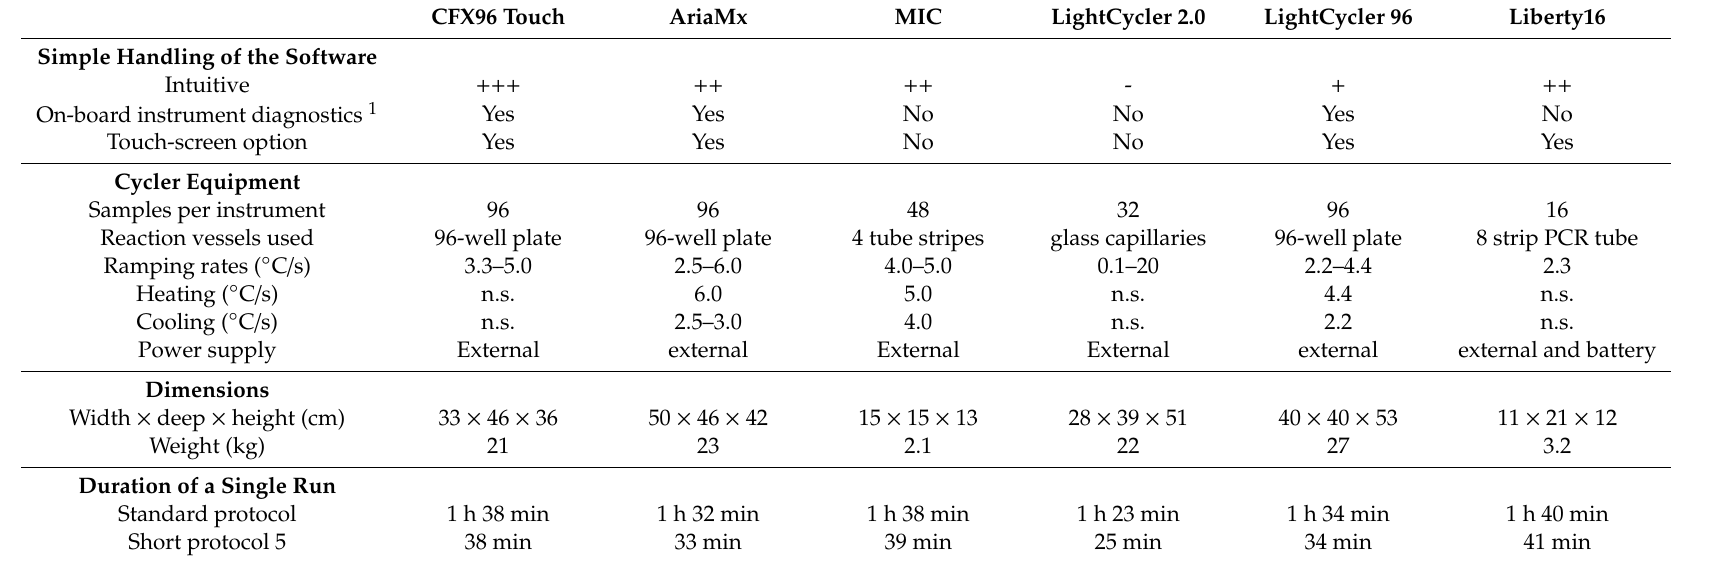
Table 2. Comparative evaluation of various qPCR-cyclers with regard to their usability as a pen-side test. CFX96